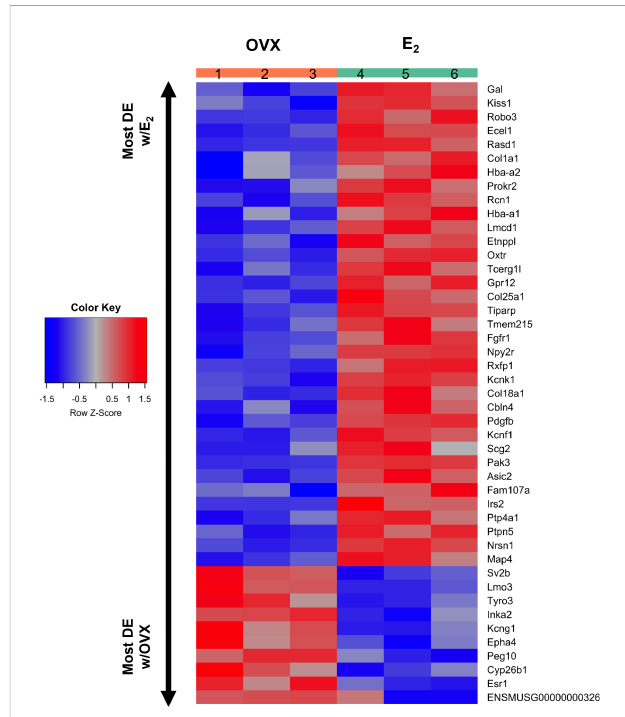
FIGURE 4 A heatmap of the 45 differentially expressed gene transcripts in MeA Kiss1 cells. Treatment conditions and pooled sample numbers are indicated at the top. Row Z-scores demonstrate the relationship between the expression level of that transcript in the sample in comparison to the total mean expression level of that transcript. Row Z-scores that are positive (red) indicate higher expression of a transcript in a sample, in comparison to the total mean expression of the transcript, whereas Row Z-scores that are negative (blue) represent lower expression of that transcript. 35 of the gene transcripts were upregulated by E 2 treatment, whereas only 10 of the gene transcripts had greater expression levels in OVX